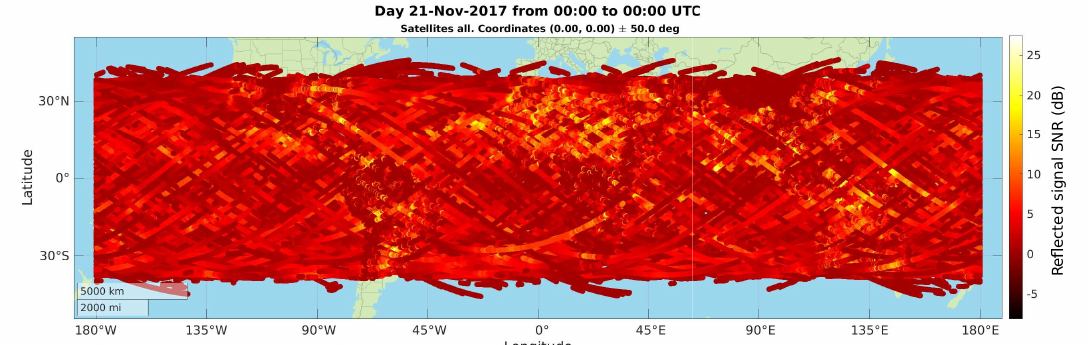
Figure 4. SNR values on specular reflection points for the full day 21 November 2017, on all regions (sea and land) from 40 ◦ S to 40 ◦ N. Values in